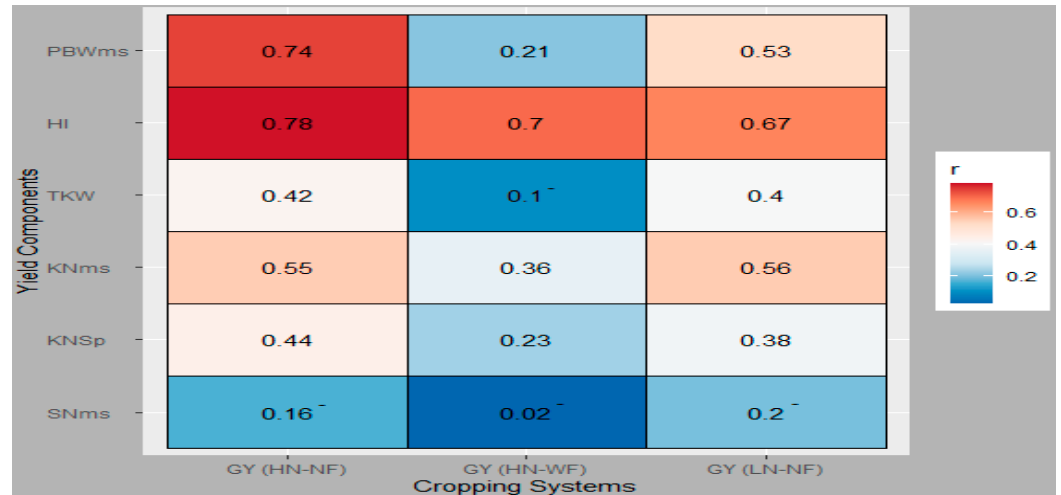
Figure 5. Correlations between GY and yield components traits under each CS. Traits were measured in a wheat population containing 220 cultivars grown under three CS between 2015 and 2017. The correlations coefficients are ranged low values (blues color) to high values (red colored). The numbers crossed with minus ( − ) are not significant at p < 0.05.